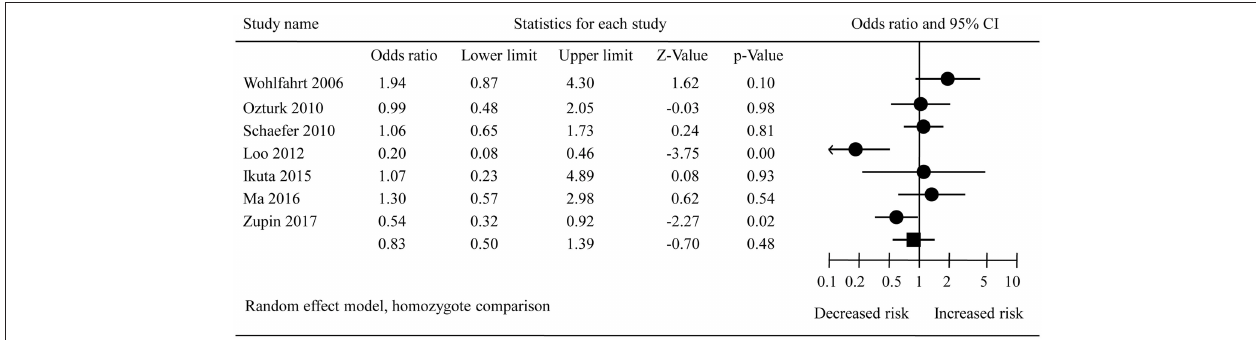
Frontiers in Genetics |